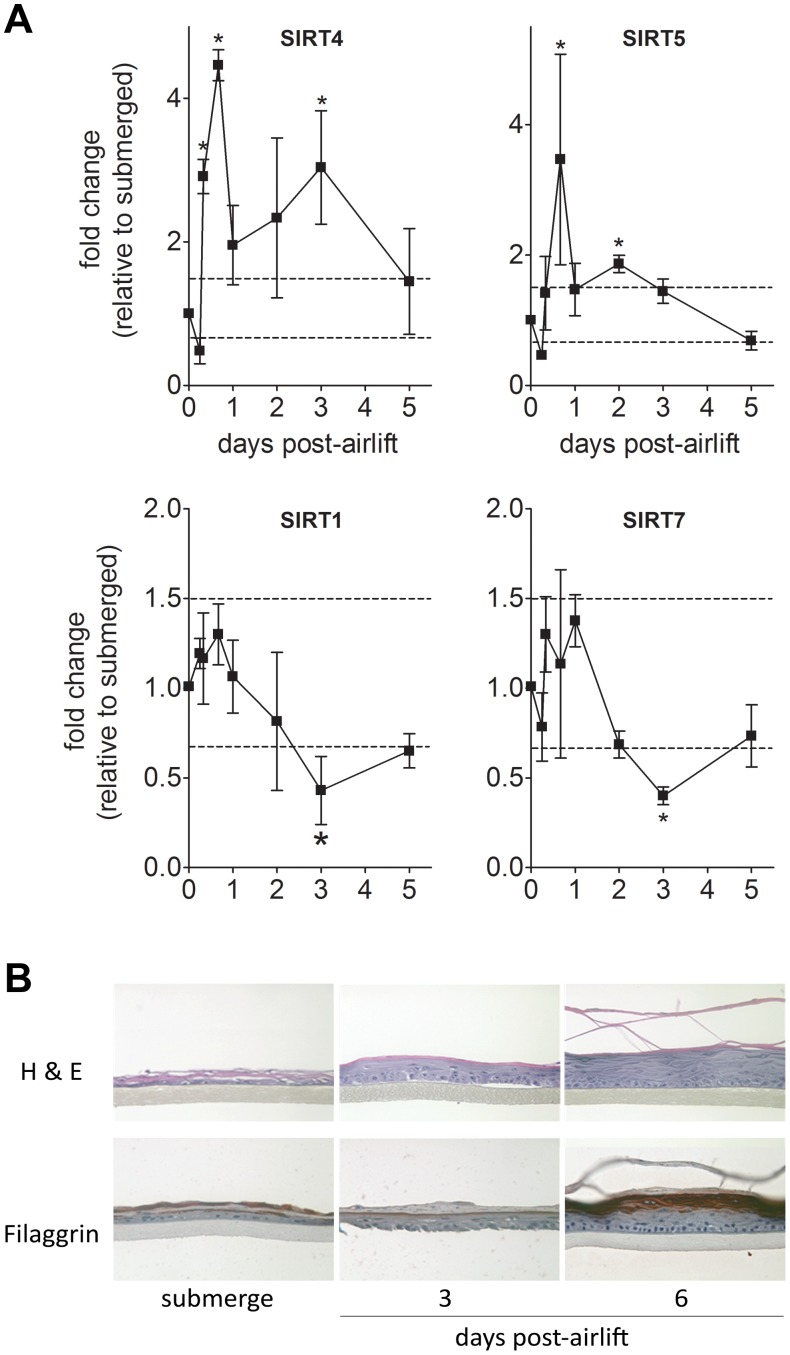
SIRT mRNA expression changes during keratinocyte differentiation.NHEK grown on a collagen-coated membrane were raised to the air-liquid interface (air-lift) to induce differentiation. (A) SIRT gene expression was measured by qPCR as a function of time. Expression levels shown are calculated as fold change relative to expression levels in submerged cultures (before airlift) after normalization to 18 S rRNA expression. Mean ± SEM, n = 4. *p<0.05 and a fold change >1.5 or <0.67 (dashed lines). (B) Hematoxylin and eosin (H&E) and filaggrin immunohistochemical staining of epidermal reconstructs reveals differentiation progress after airlift.